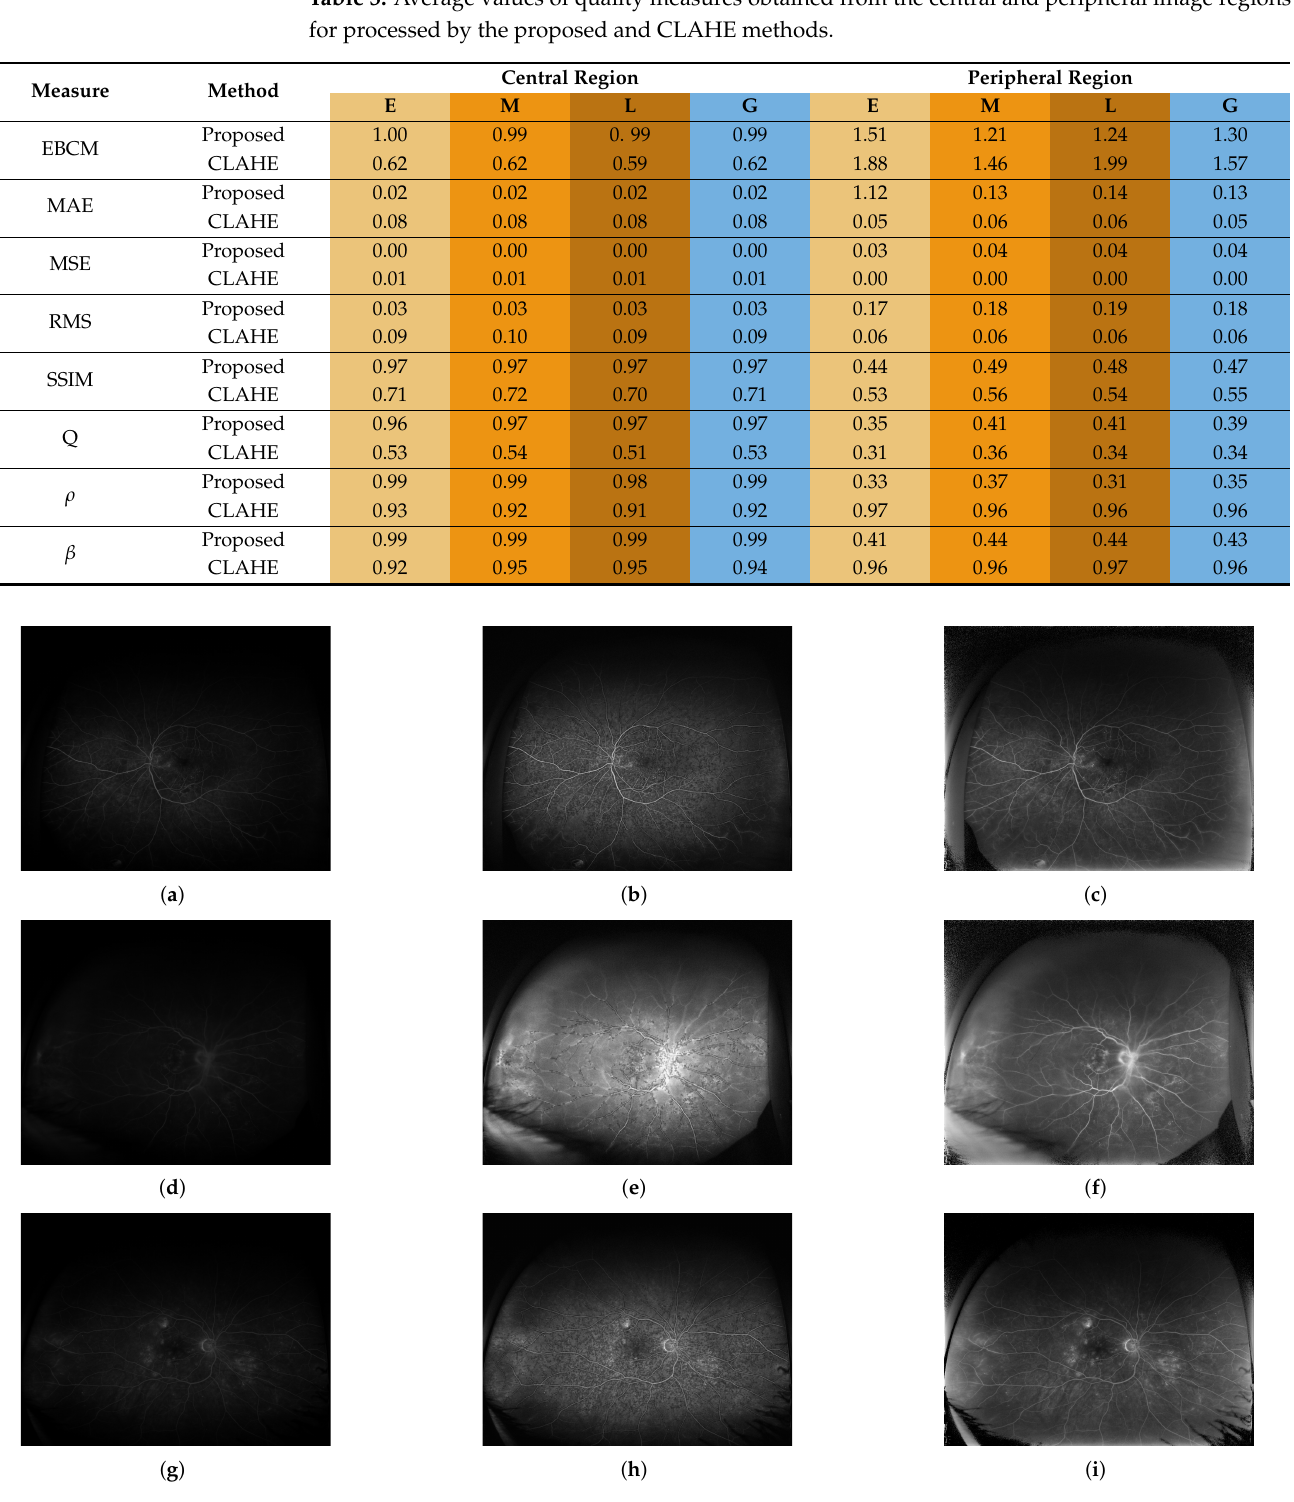
Figure 9. Visual comparison of the results obtained for several input images ( a , d , g ) by the CLAHE method ( b , e , h ) and the proposed method ( c , f , i ) for three phases: early (first row), mid (middle row) and late (last row).